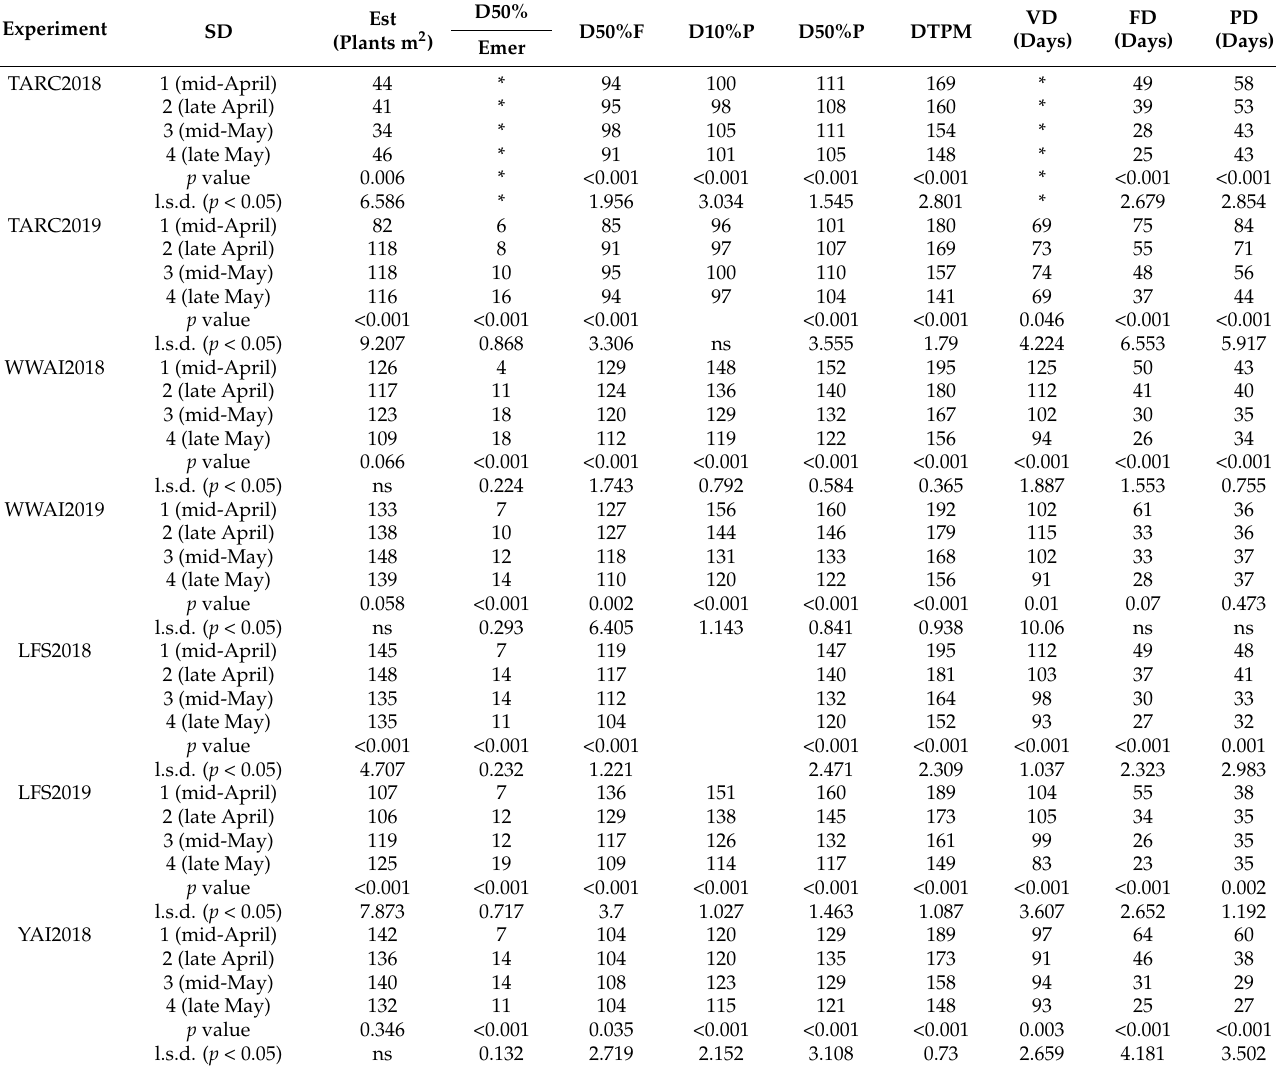
Table 2. Influence of sowing date on key lentil development phases. SD = Sowing Date, Est = establishment; D50%emer = days to 50% emergence; D50%F = days to 50% flowering; D10%P = days to 10% podding; D50%P = days to 50% podding; DTPM = days to